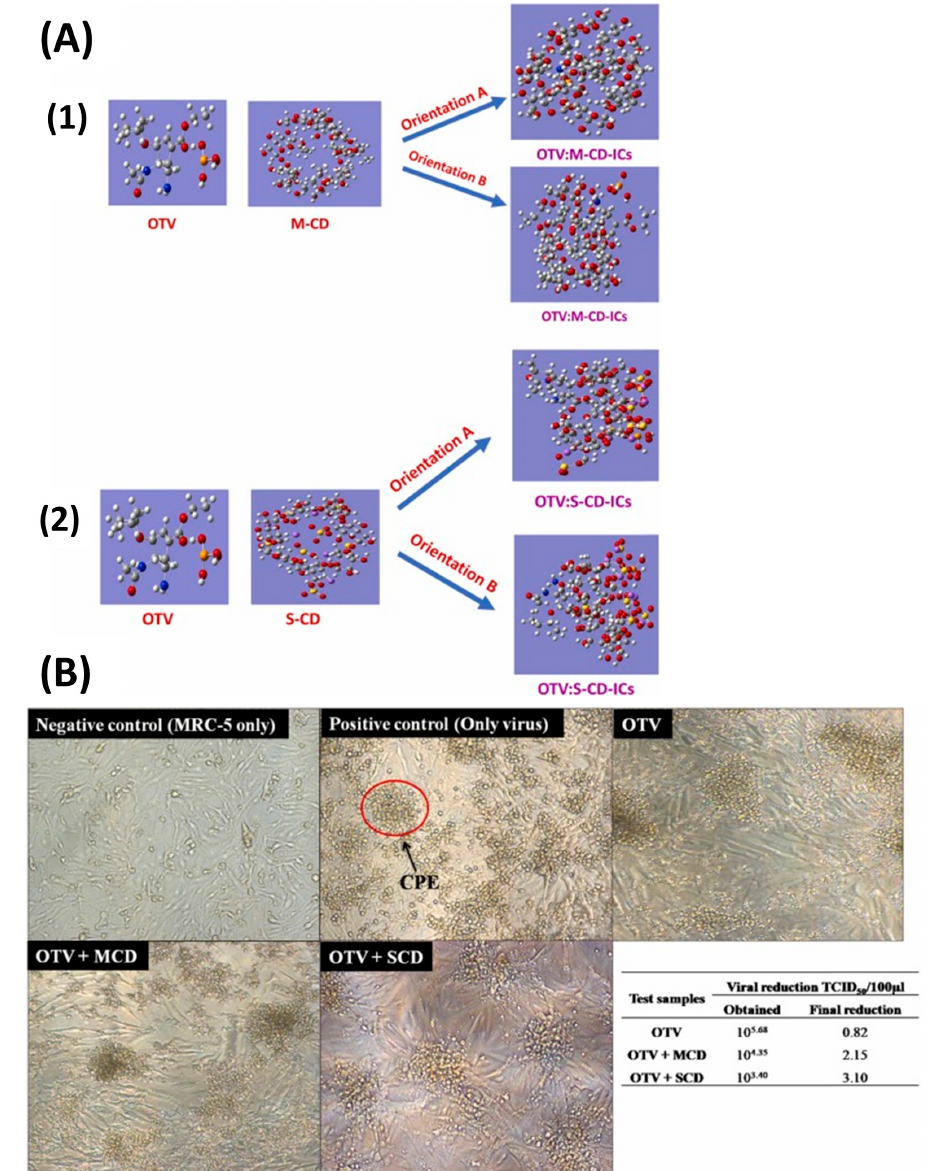
Figure 8. ( A ) Oseltamivir (OVT) orientation in (1) methylated- β -Cyclodextrin (M-CD) and (2) sulfated- β -Cyclodextrin (S-CD) inclusion complexes and ( B ) their antiviral effects in HCoV-229E infected MRC-5 cells. Briefly, OVT offers increased antiviral activity with more pronounced effects when using S-CD. Reprinted from [66], Copyright (2022), with permission from